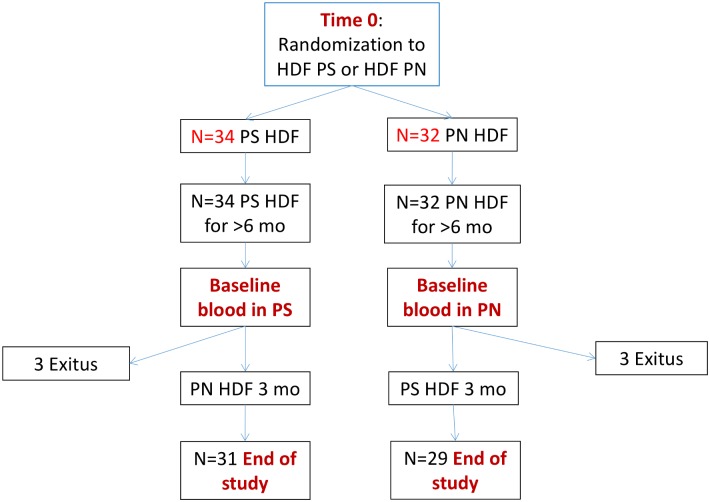
Patient flow chart.